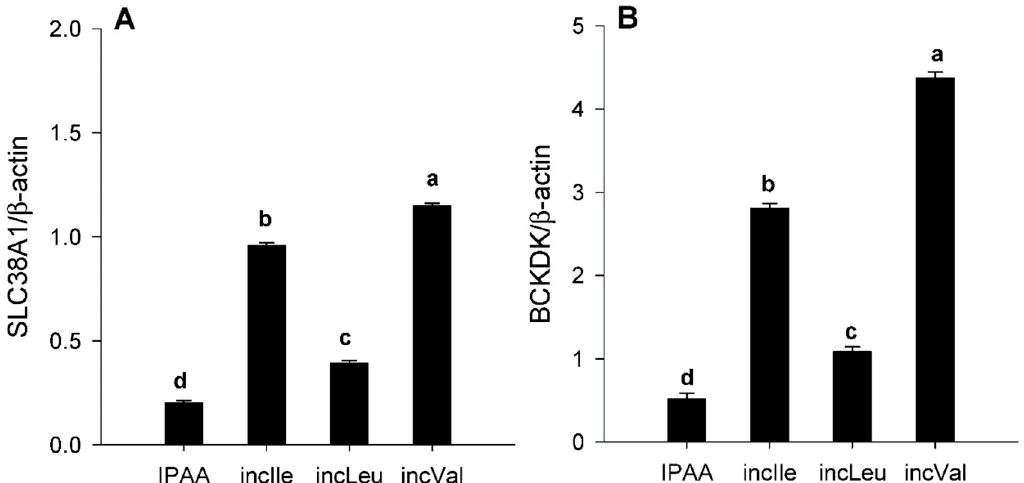
Figure 3. Protein abundance (relative to β -actin) of the Gln transporter SLC38A1 (panel ( A )) and branched chain keto acid dehydrogenase kinase (BCKDK, panel ( B )) in s.c. adipose tissue cultured with different levels of Leu, Ile, or Val. Control media contained an ideal AA profile (IPAA; Lys:Met 2.9:1, Lys:Val 1.23:1; Lys:Ile 1.45:1; Lys:Leu 0.85:1). Treatment media was supplemented with greater amounts of Leu, Ile, or Val to achieve ratios of Lys:Leu 0.78:1 (incLeu), Lys:Ile 1.29:1 (incIle), or Lys:Val 1.12:1 (incVal). Different letters indicate differences between treatments ( p < 0.05) using the Tukey multiple comparison procedure in SAS v.9.4 (SAS Institute Inc., Cary, NC, USA). Data are LS means, n = 4 cows per group, ± pooled SEMs.